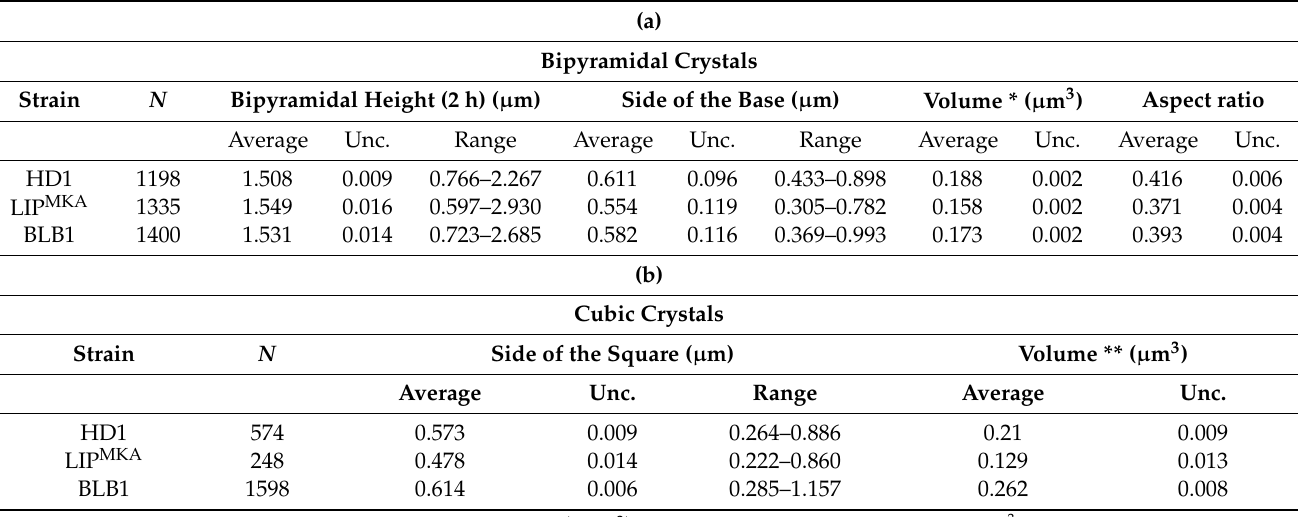
Table 2. Morphological data of the crystals of the three B. thuringiensis var. kurstaki (a) bipyramidal and (b) cubic crystals for N measurements.